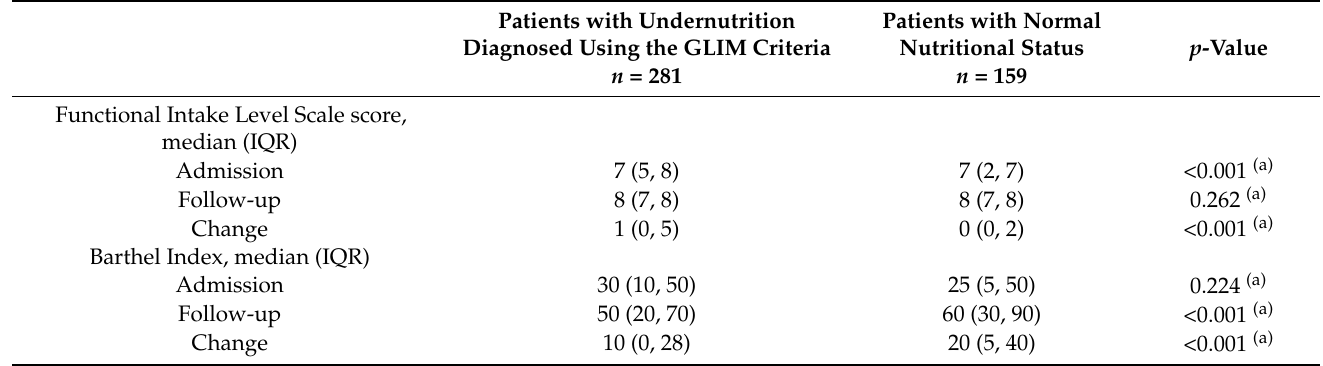
Table 3. Univariate analysis of Functional Intake Level Scale score and Barthel